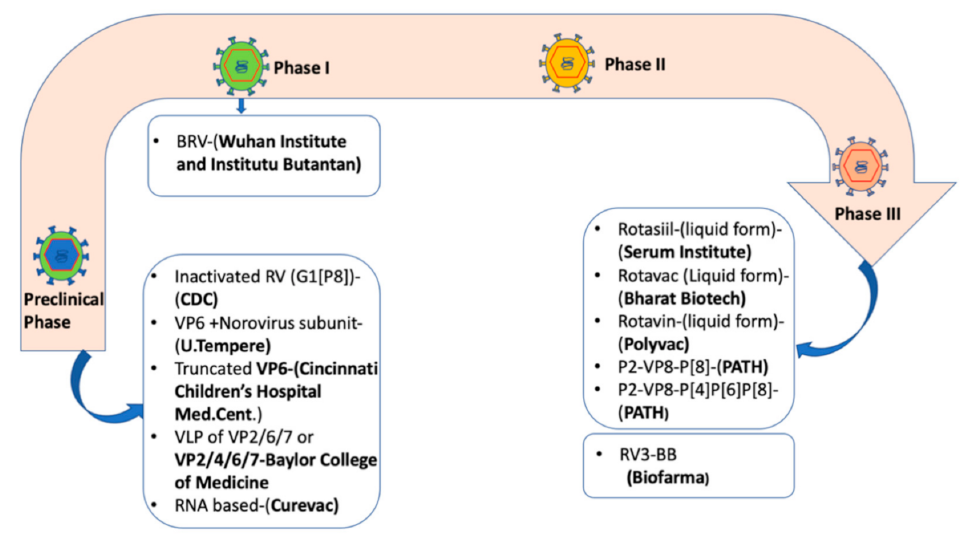
Figure 1. Rotavirus vaccine candidates in development as of March 2021 [5,6]. Abbreviations: BRV = bovine rotavirus pentavalent vaccine, VLP = virus-like particle, RV = Rotavirus vaccine, CDC = Centre for Disease